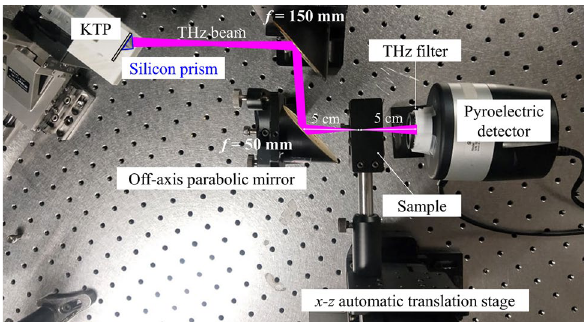
Figure 7. The experimental setup for performing scanning shadow imaging, wherein the THz wave is focused to the sample and the transmittance of it is recorded by a bulk pyroelectric